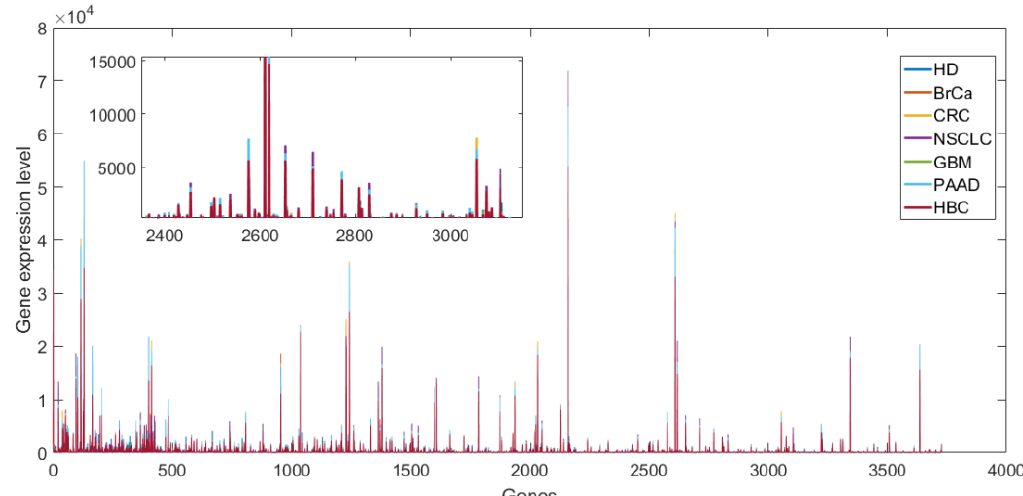
Figure 3. The average gene expression levels of each class in dataset 15.